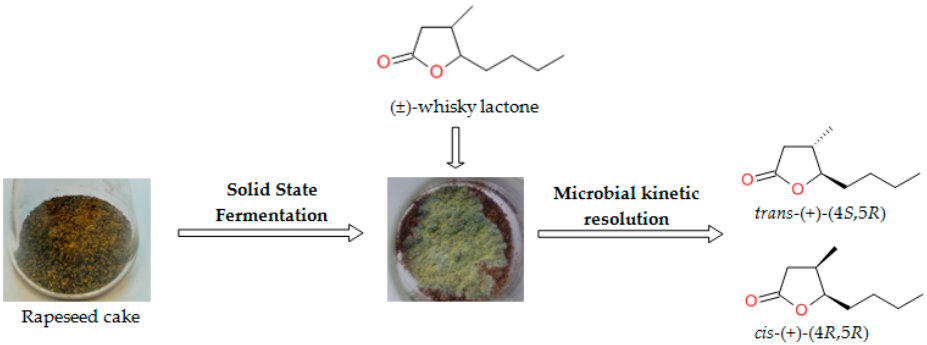
Figure 1. Microbial kinetic resolution of whisky lactone by solid-state fermentation (SSF).